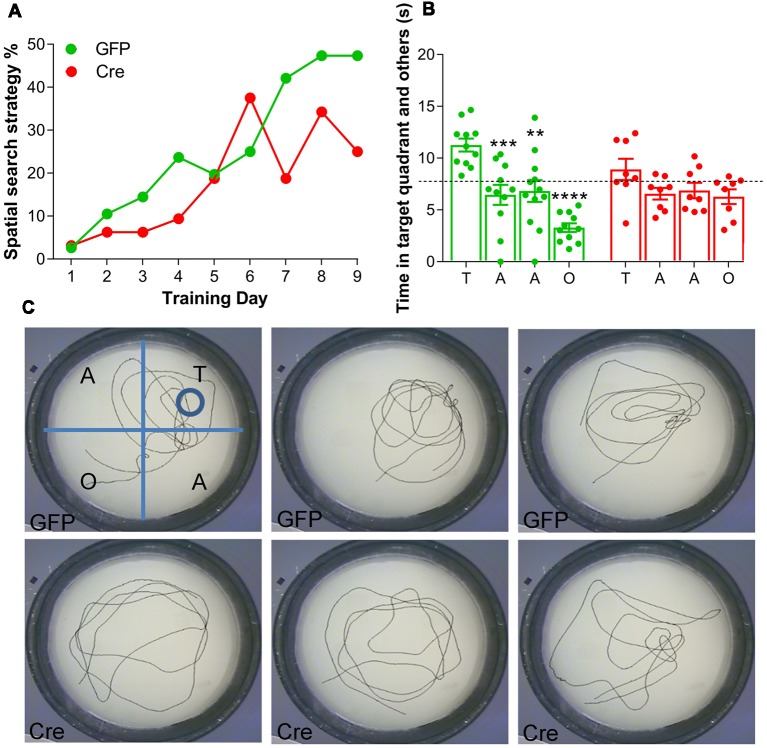
Effect of RXFP3 depletion in the MS/DB of adult, floxed-Rxfp3 mice on learning and long-term reference memory in the Morris Water Maze (MWM) test. (A) Mice with RXFP3 depleted from the MS/DB were less likely to adopt a spatial search strategy across the acquisition days, relative to eGFP-injected control mice [treatment: OR: 0.56, 95% CI (0.33; 0.96), p = 0.034]. (B) On the probe day, AAV(1/2)-eGFP mice spent significantly more time in the target quadrant relative to the other quadrants in the first 30 s bin, whereas, AAV(1/2)-Cre-IRES-eGFP mice did not spend more time in the target quadrant relative to the other quadrants in the same 30 s period (one-way analysis of variance (ANOVA), Bonferroni post-hoc analysis, **p < 0.01, ***p < 0.001, ****p < 0.0001, n = 8–12 mice per group). (C) Examples of swim tracks during the first 30 s on probe day of three representative (upper) AAV-eGFP injected mice (GFP1–3) and (lower) AAV(1/2)-Cre-IRES-eGFP mice (Cre1–3).